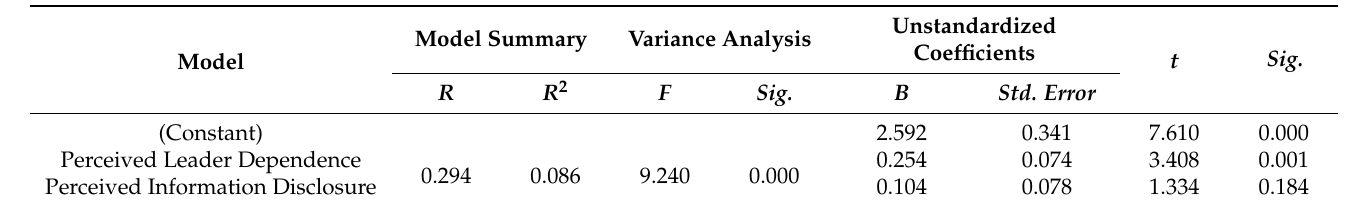
Table 14. Regression Analysis of Perceived Leader Trust on Work Meaning.